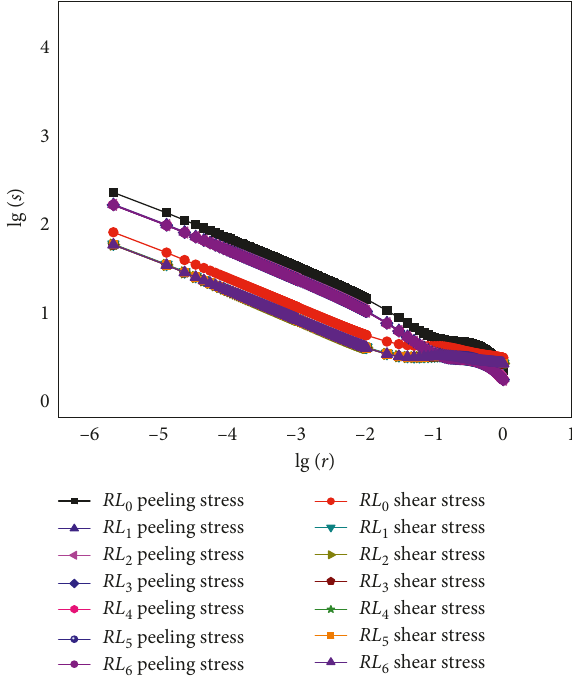
Figure 3: Stress distributions near the singularity point A. Figure 4: lg